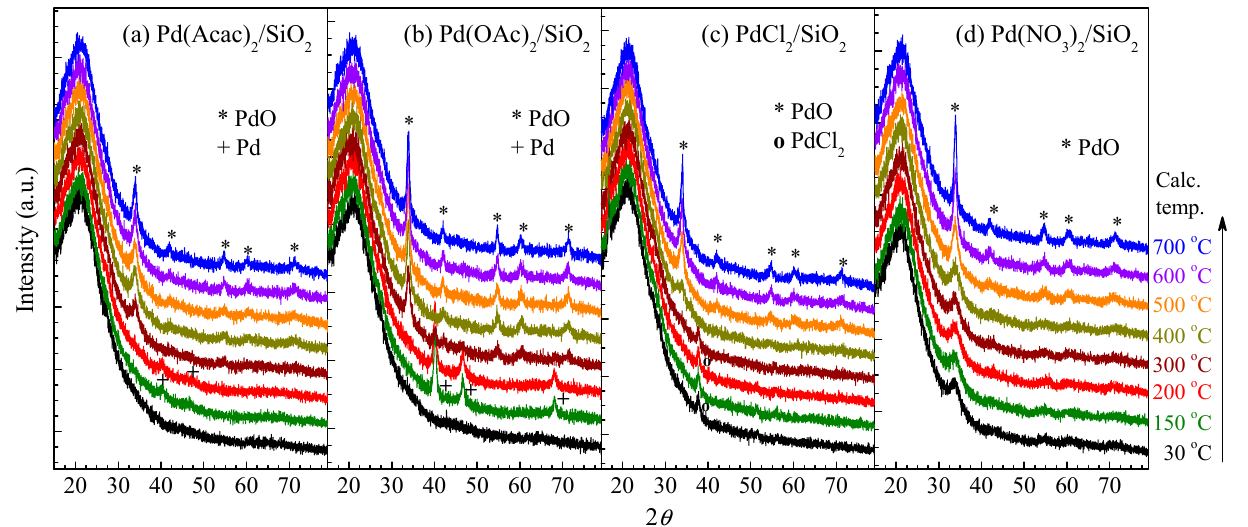
Figure 2. XRD patterns of the mixture of SiO 2 support + different Pd precursors from dry ball-milling, collected after calcination at step-wise elevated temperatures (from bottom up, corresponding to 30, 150, 200, 300, 400, 500, 600 and 700 °C in sequences, as marked right in the legend): ( a ) Pd(Acac) 2 /SiO 2 , ( b ) Pd(OAc) 2 /SiO 2 , ( c ) PdCl 2 /SiO 2 , and ( d ) Pd(NO 3 ) 2 /SiO 2 .